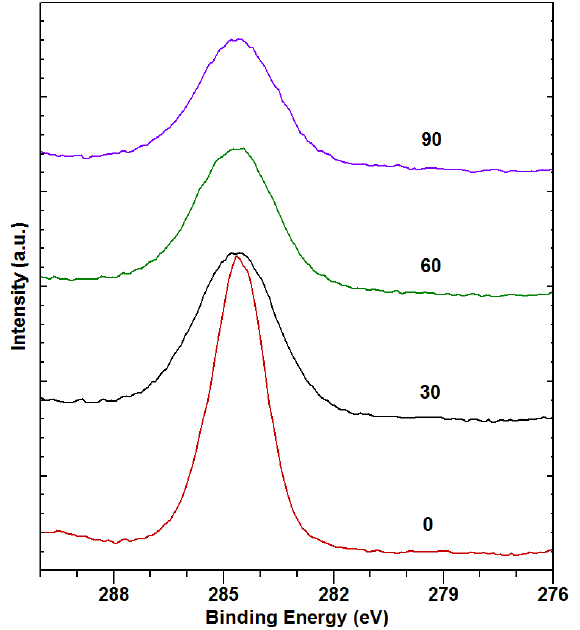
Figure 2. Typical C 1s peak intensities after different sputtering times (in minutes).